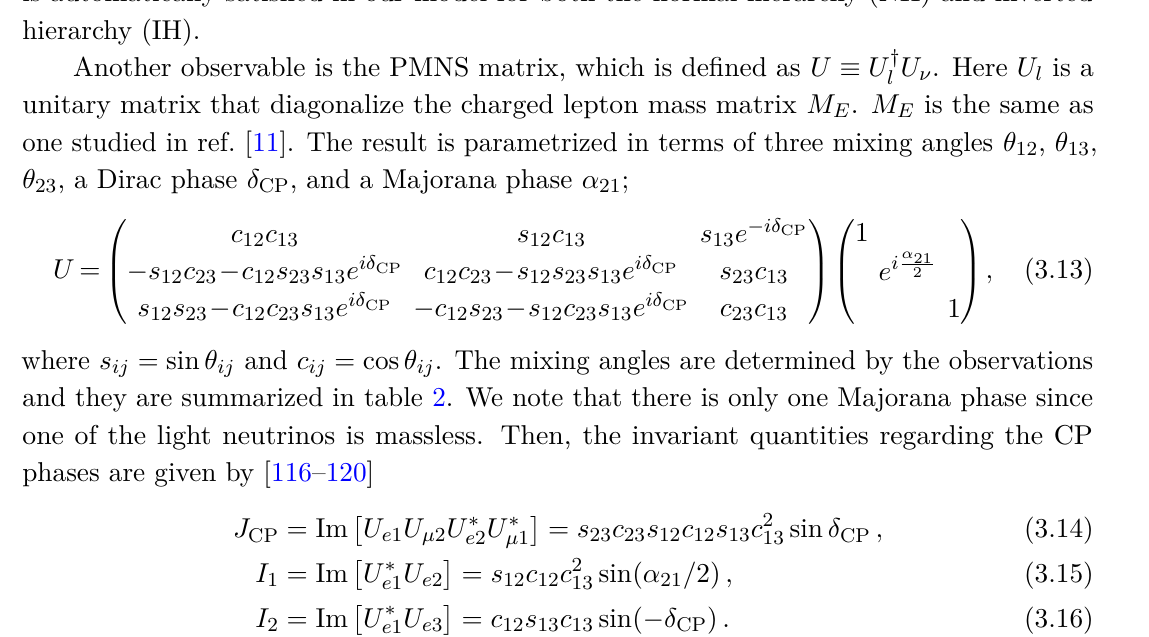
= ∆ m 2 31 > 0 (NH) and ∆ m 2 = ∆ m 2 32 < 0 3 l 3 l